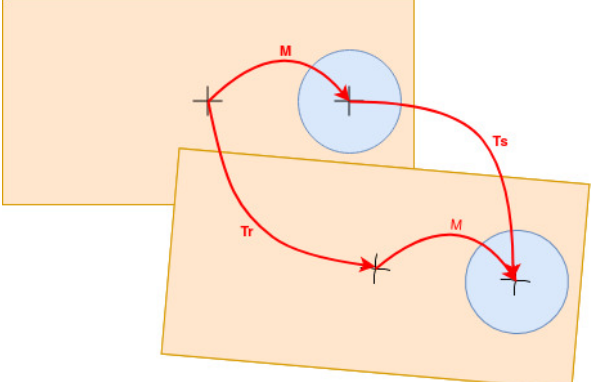
Figure 5. Transformation of coordinate systems in calibration using the least squares